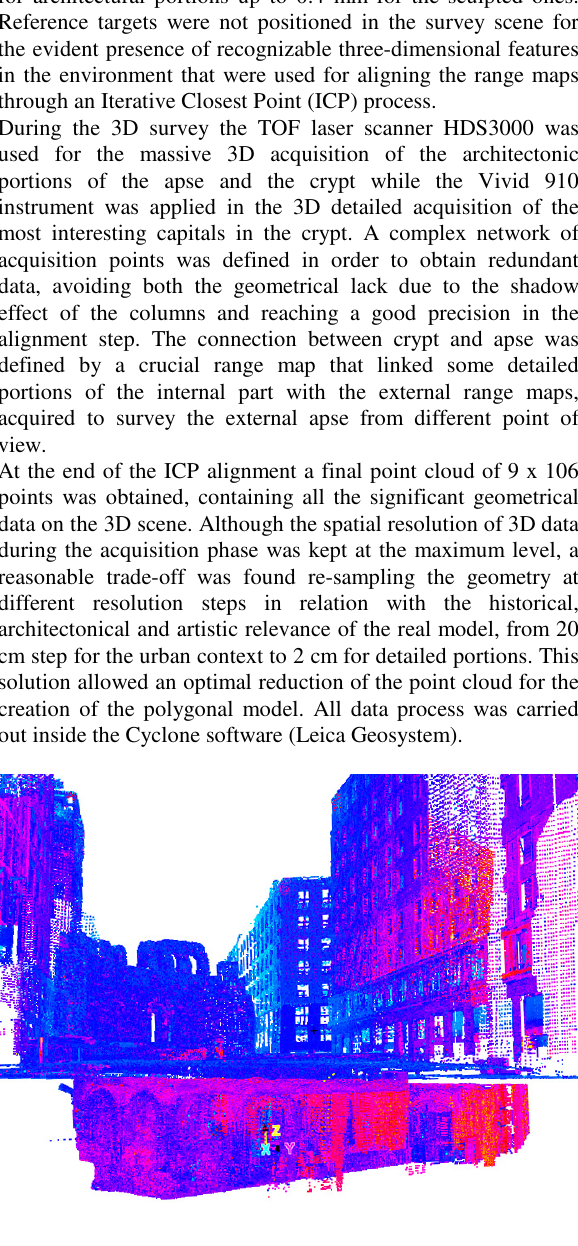
Figure 3. Final aligned point cloud of the crypt, the apsidal ruins and part of the surrounding environment.